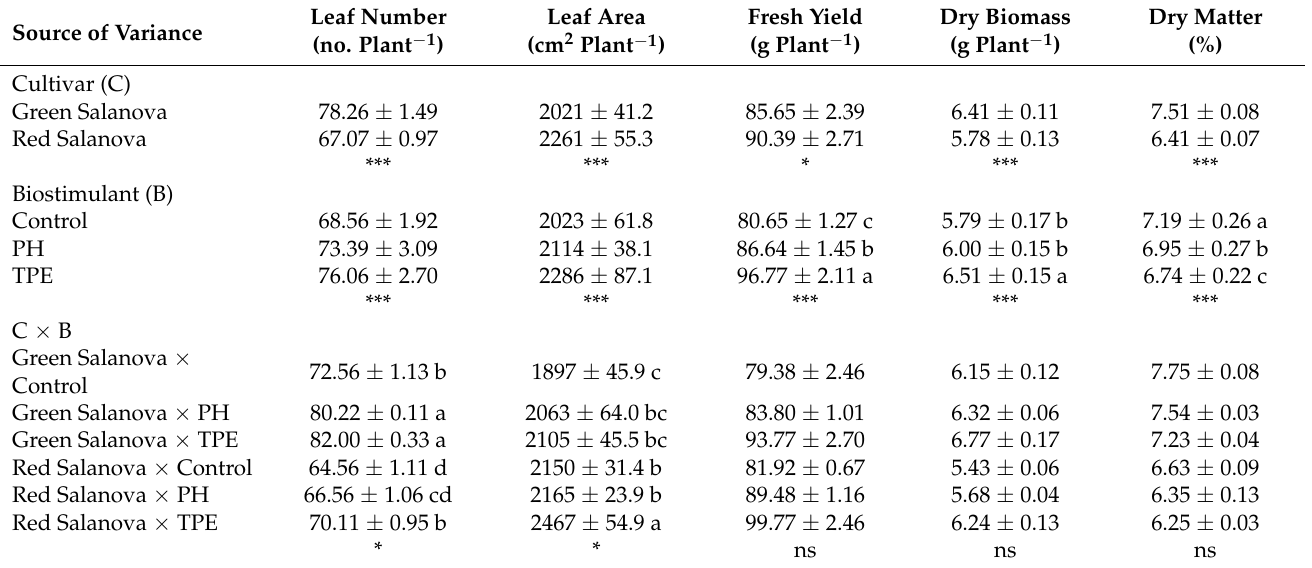
Table 1. Yield and biometric parameters of red and green salanova lettuce and influence of biostimu- lant treatments.